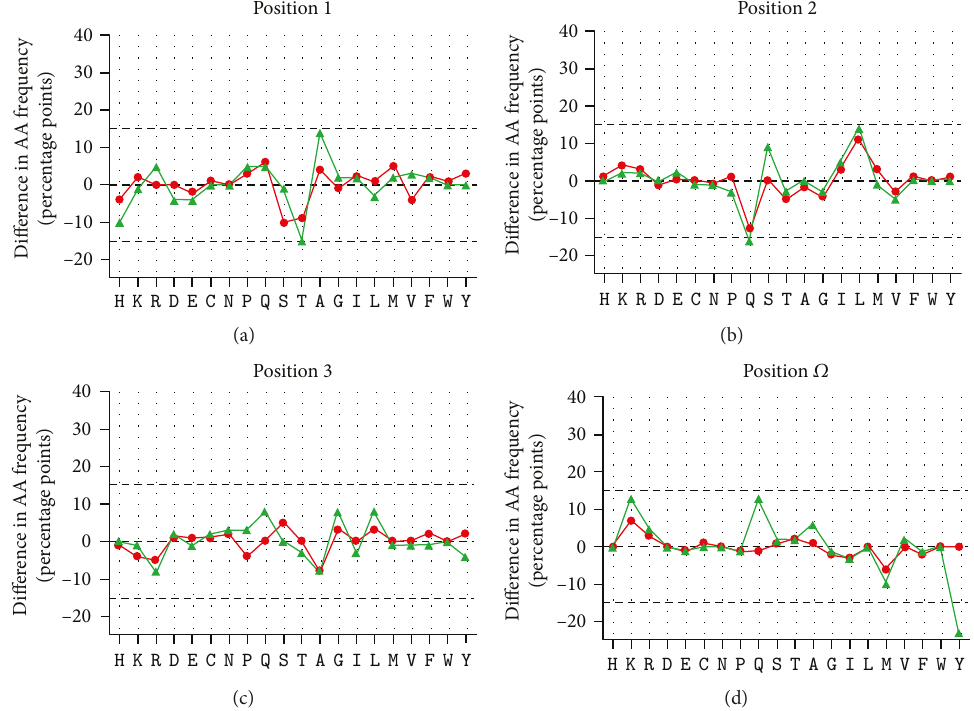
Figure 3: Alteration of peptides bound to B ∗ 15:02/CBZ or B ∗ 15:02/EPX complexes. The alterations of AA frequency after treatment with CBZ (red) and EPX (green) are depicted at p1 (a), p2 (b), p3 (c), and p Ω (d). The graphs for CBZ and EPX were adjusted to the data of AA frequencies obtained without drug treatment (black). The data have been obtained from triplicate